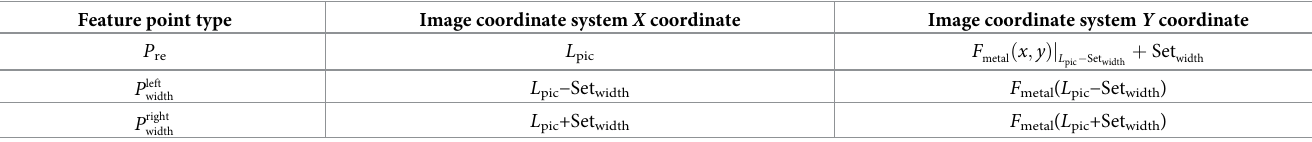
Table 1. Simulation feature point position of normal weld contour